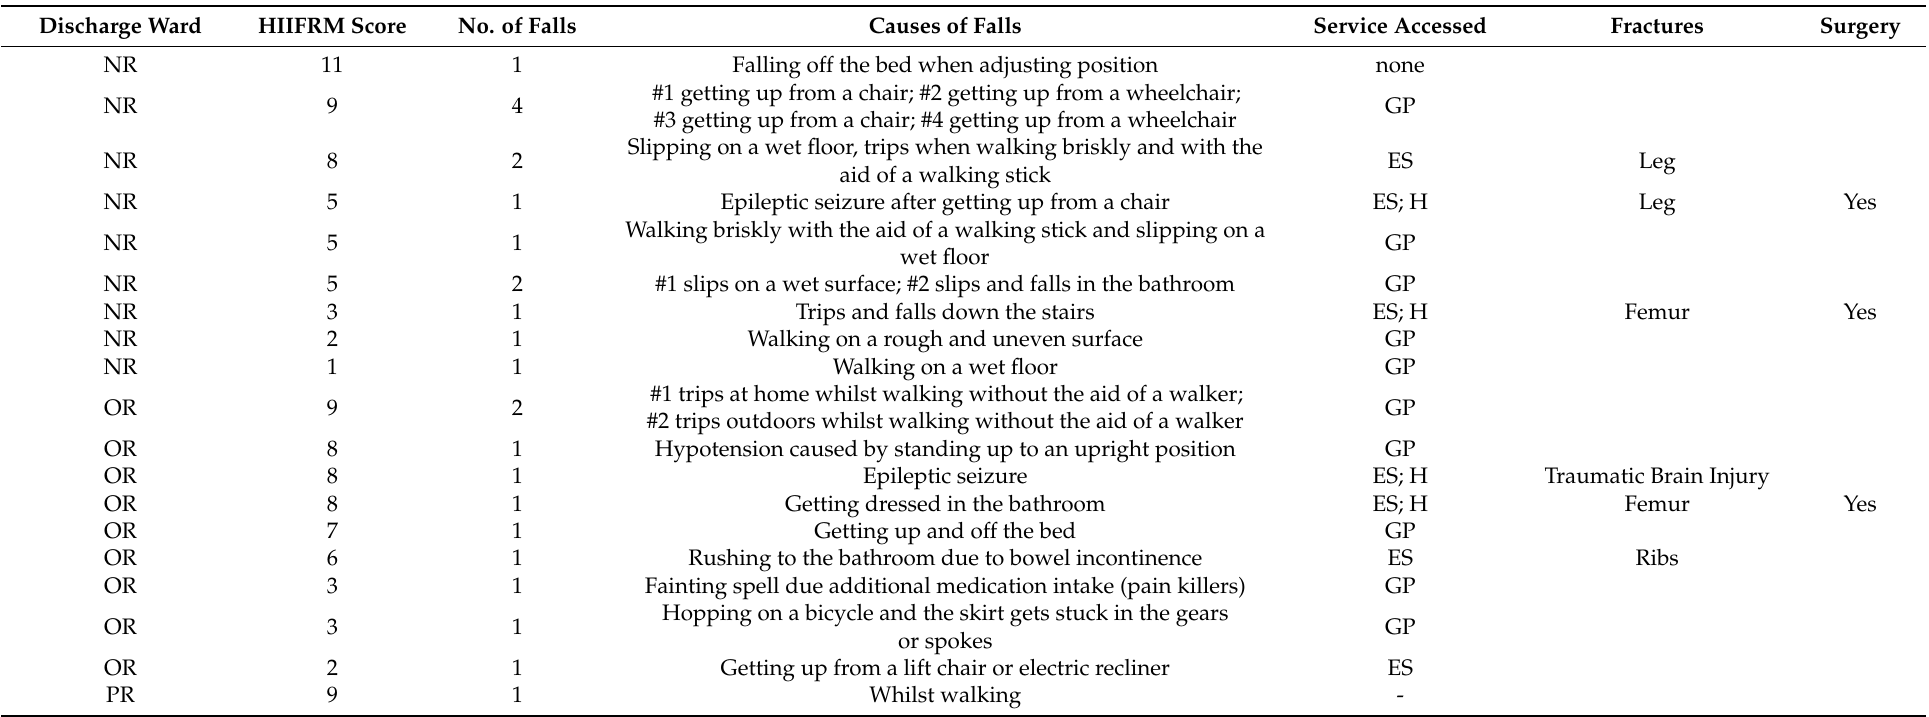
Table 4. Description of fall causes and